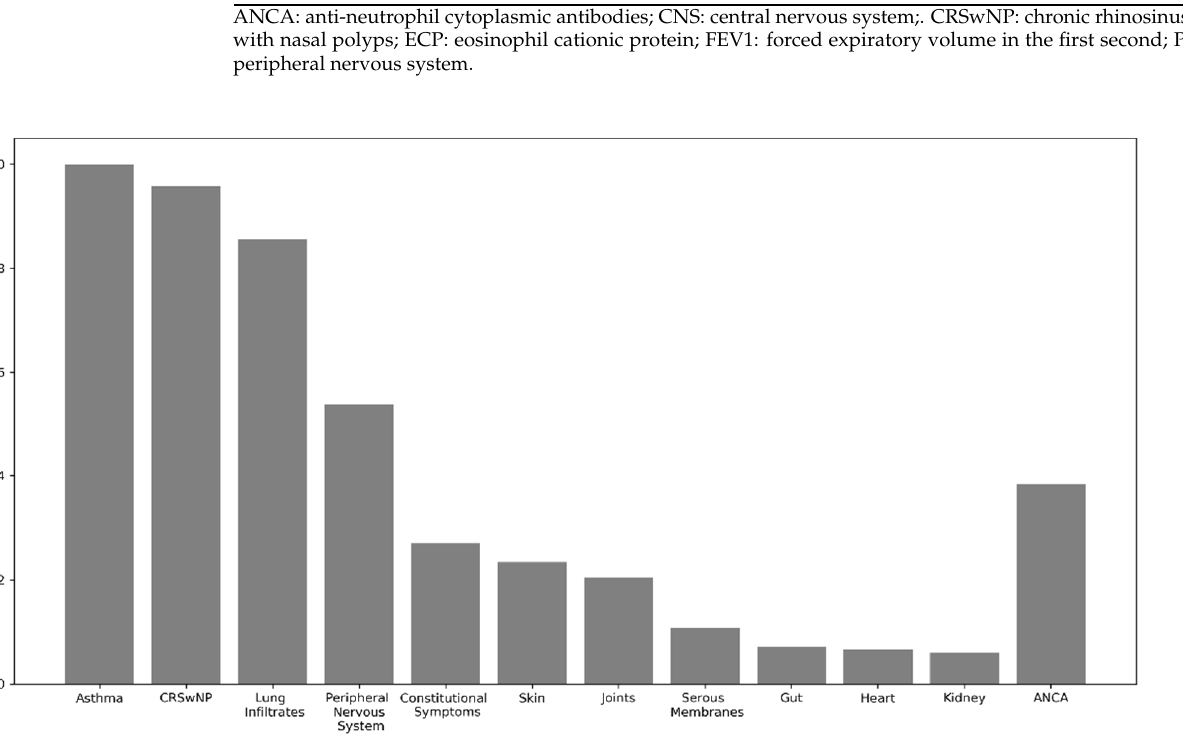
Figure 2. Detailed organ involvement in our cohort. CRSwNP: chronic rhinosinusitis with nasal